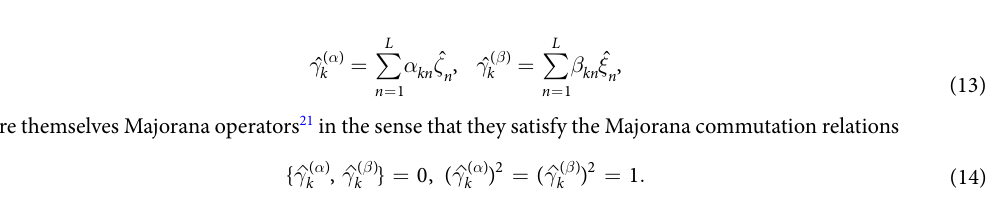
are themselves Majorana operators 21 in the sense that they satisfy the Majorana commutation relations γ The latter property follows from the fact that the vectors α kn and β kn are normalized and mutually orthogonal. By definition, the Majorana operators (13) are nonlocal linear combinations 21 of the more conventional 40 Majorana fermions (11). Typically, these combinations involve all sites of the chain 21 . However, for the two lowest excited states (7)–(10) the amplitudes α 1(2) n and β 1(2) n exhibit the exponential decay away from the interface points of the chain, allowing one to treat the nearly zero-energy Majorana states γ α ˆ 1(2)( ) and γ β ˆ 1(2)( ) as essentially localized 21 , see Figs 5 and 6.